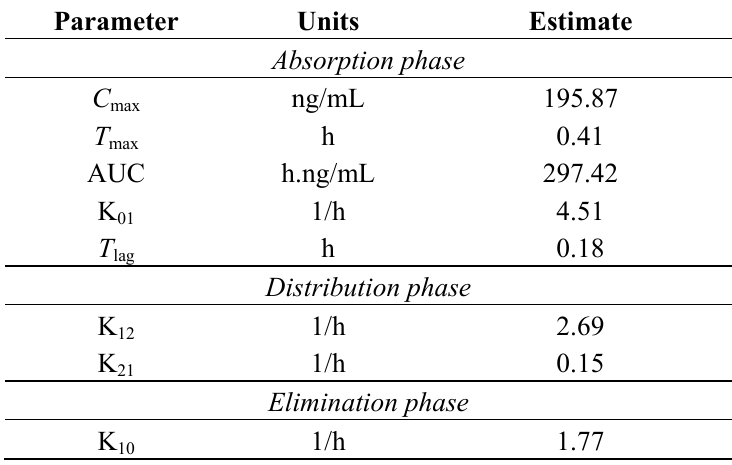
Table 3. Pharmacokinetic parameters calculated using the best fit